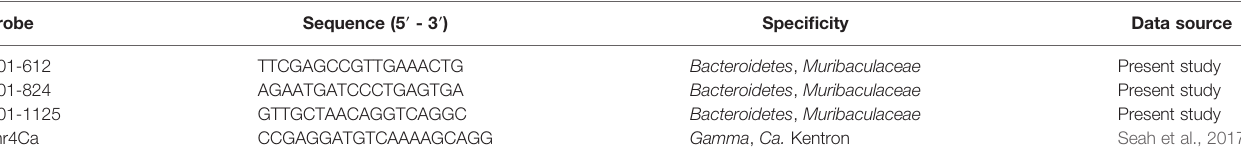
Gamma indicates the bacterial class